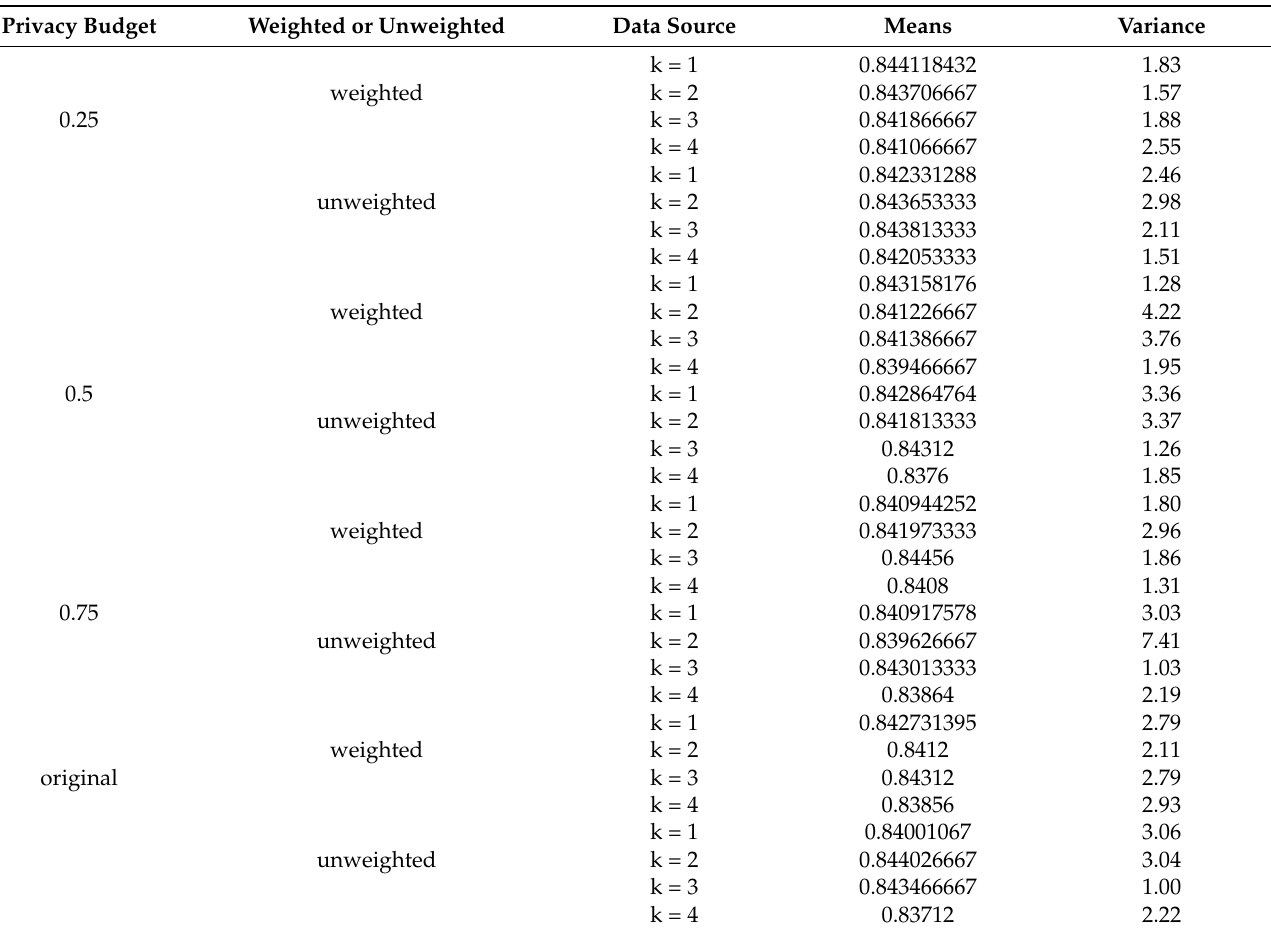
Table 10. The performance table of the initial global H 3 model for the federated average algorithm in the t 4